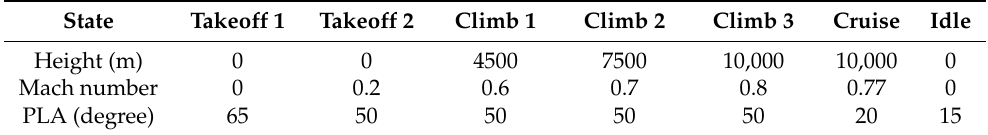
Table 1. Simulation status